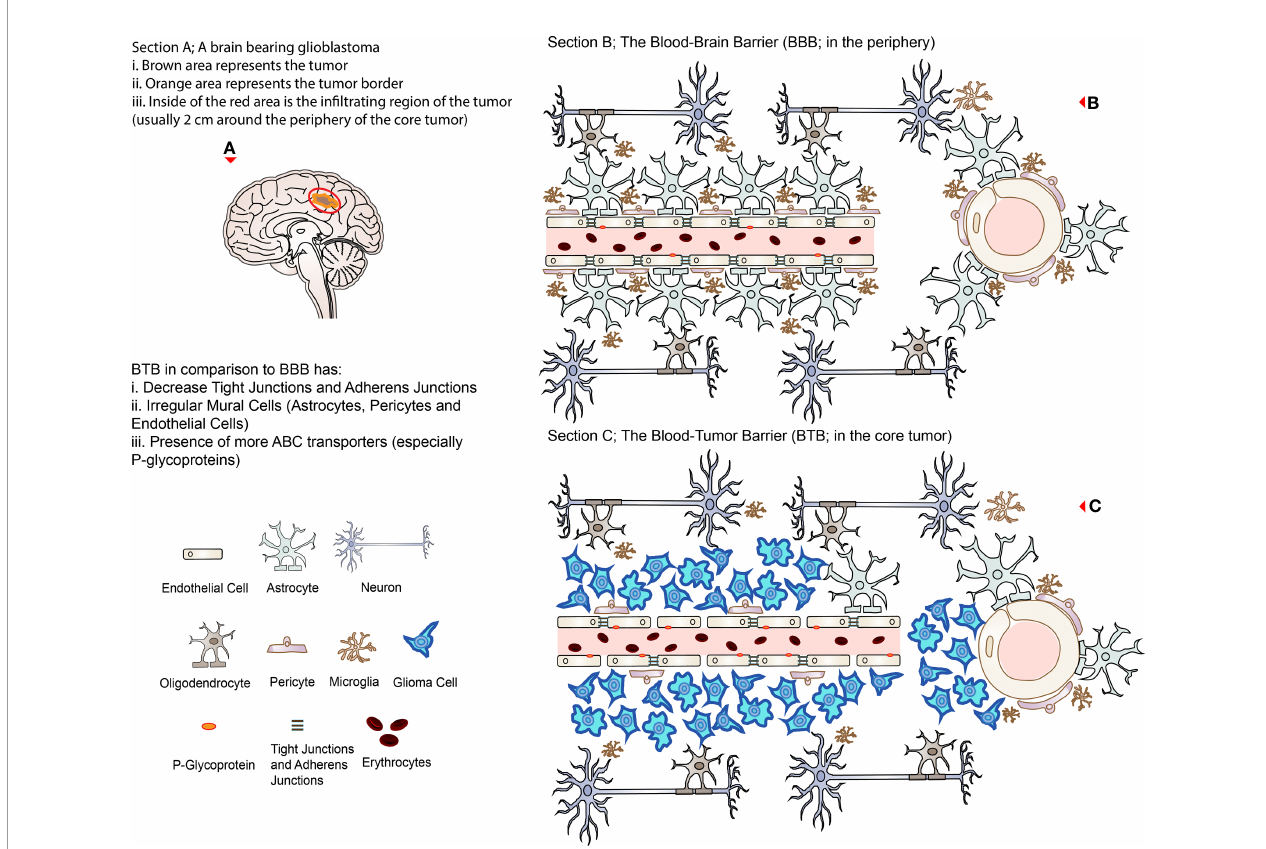
FIGURE 1 | Representing illustrations of BBB and BTB. (A) A brain bearing glioblastoma (brown with orange border) with an invisible in fi ltrating region approximately 2 cm around the lesion (circled in red representing the region of recurrence after surgical excision). (B) The BBB in association with other cells present in the healthy brain microenvironment; the right side represents the cross-section of the cerebral vessels. (C) The BTB in the core of a glioblastoma; the right side represents the cross-section of the cerebral vessels. Note that TJs are disrupted, and ABC transporters (P-glycoprotein) are relatively increased in the BTB compared to the